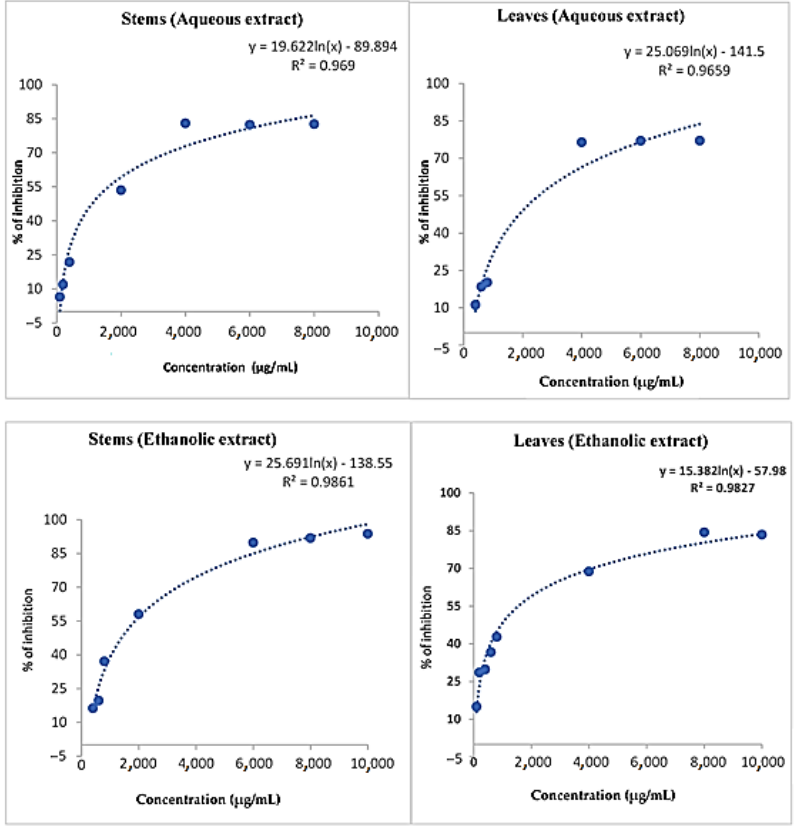
Figure 2. DPPH free radical scavenging activity curves of water and ethanol extracts of leaves and stems. Table 5. Percentage of DPPH free radical inhibition of water and ethanol extracts of leaves and